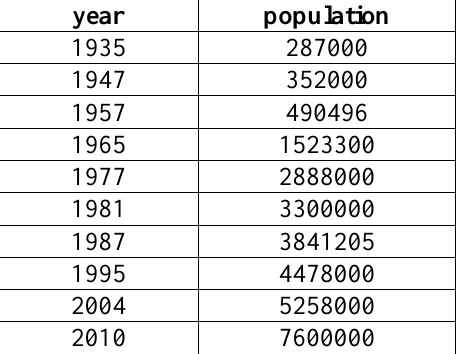
Table 1: The approximate population of Baghdad from 1935 to